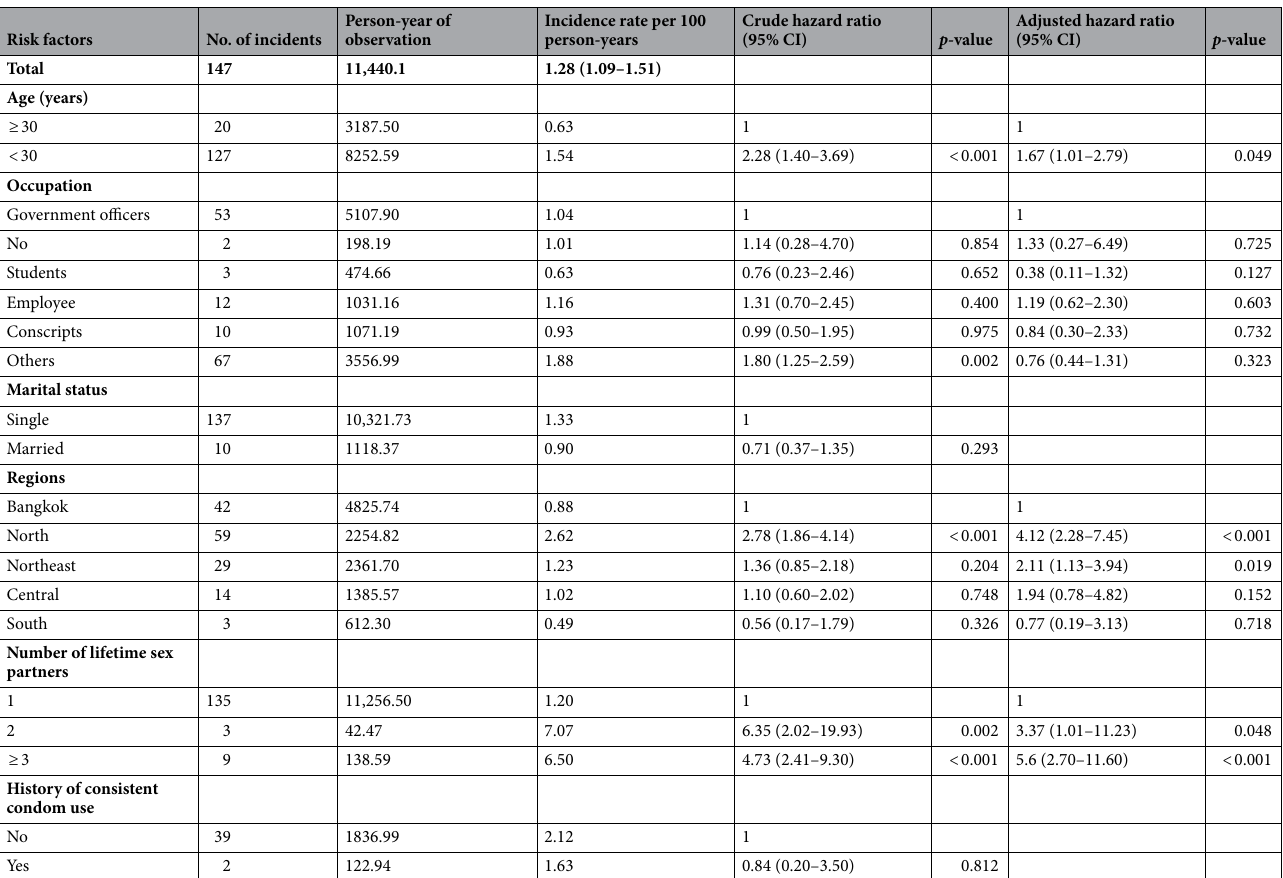
Table 2. Risk factors for gonococcal urethritis reinfection among male patients visiting in the RTA hospitals. Multivariate cox regression analysis (adjusted for age, occupation, regions, number of lifetime sex